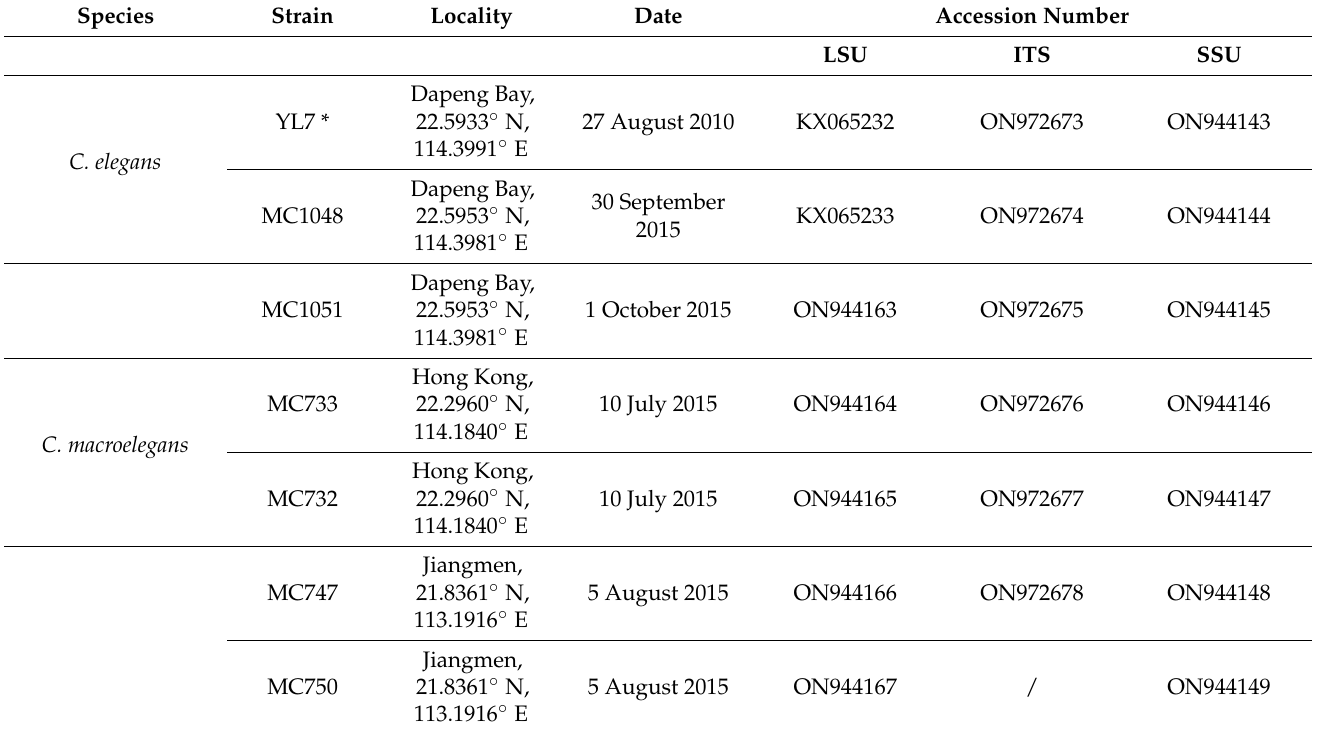
Table 1. Strains of C. elegans , C. macroelegans sp. nov and C. densoelegans sp. nov. used in this study, showing strain designation, sampling location and date, as well as ITS, LSU and SSU accession numbers. * represents holotype/means no